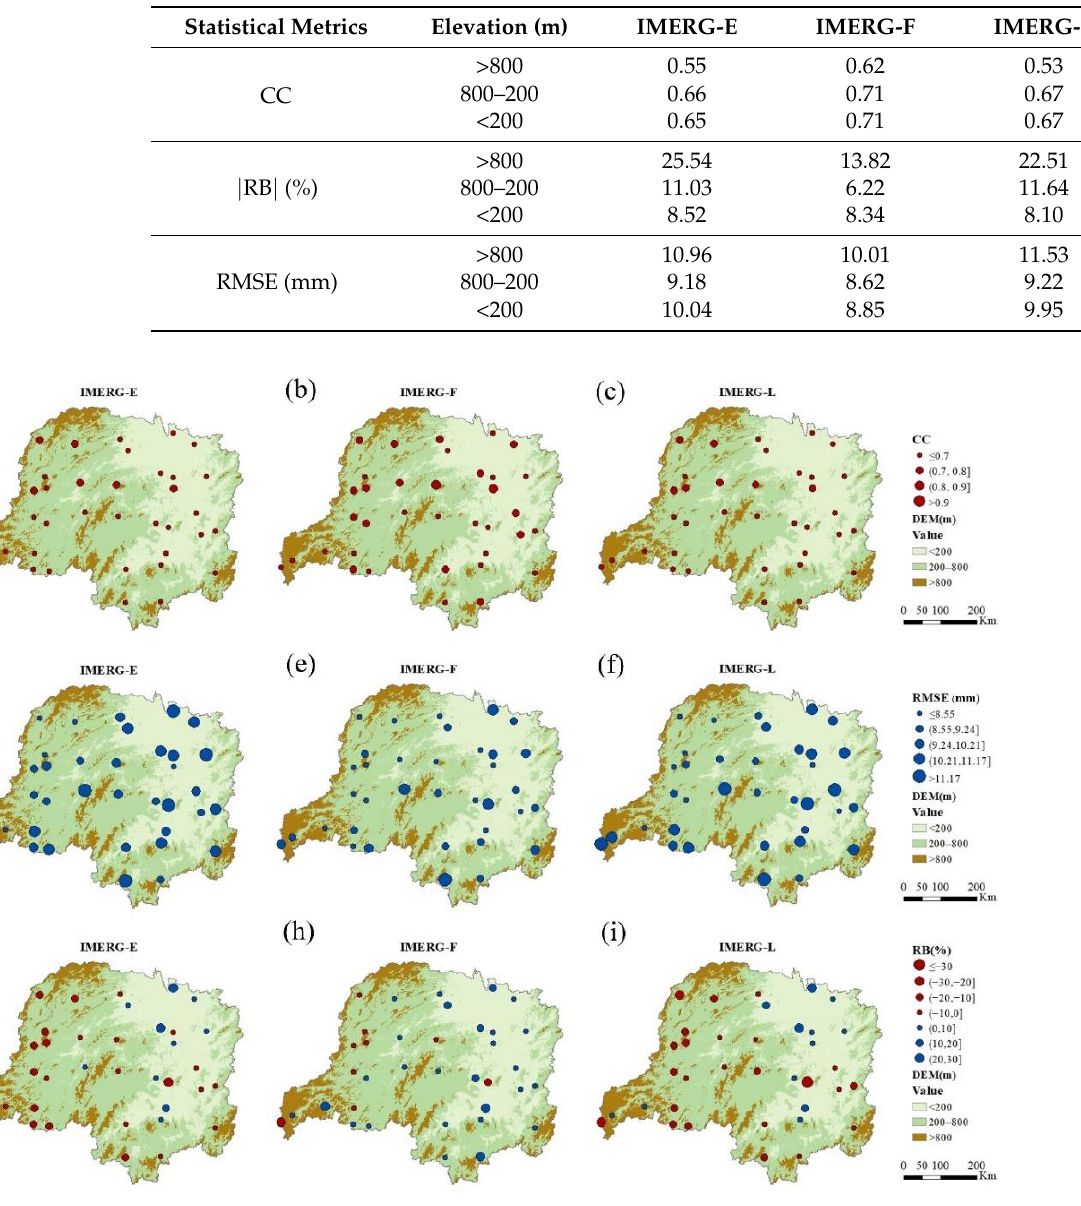
Figure 2. Spatial distribution of correlation coefficient ( a – c ), root mean square error ( d – f ), and relative bias ( g – i ) between IPPs and gauged observation at daily time scale from September 2014 to February 2021 in the Dongting Lake basin.